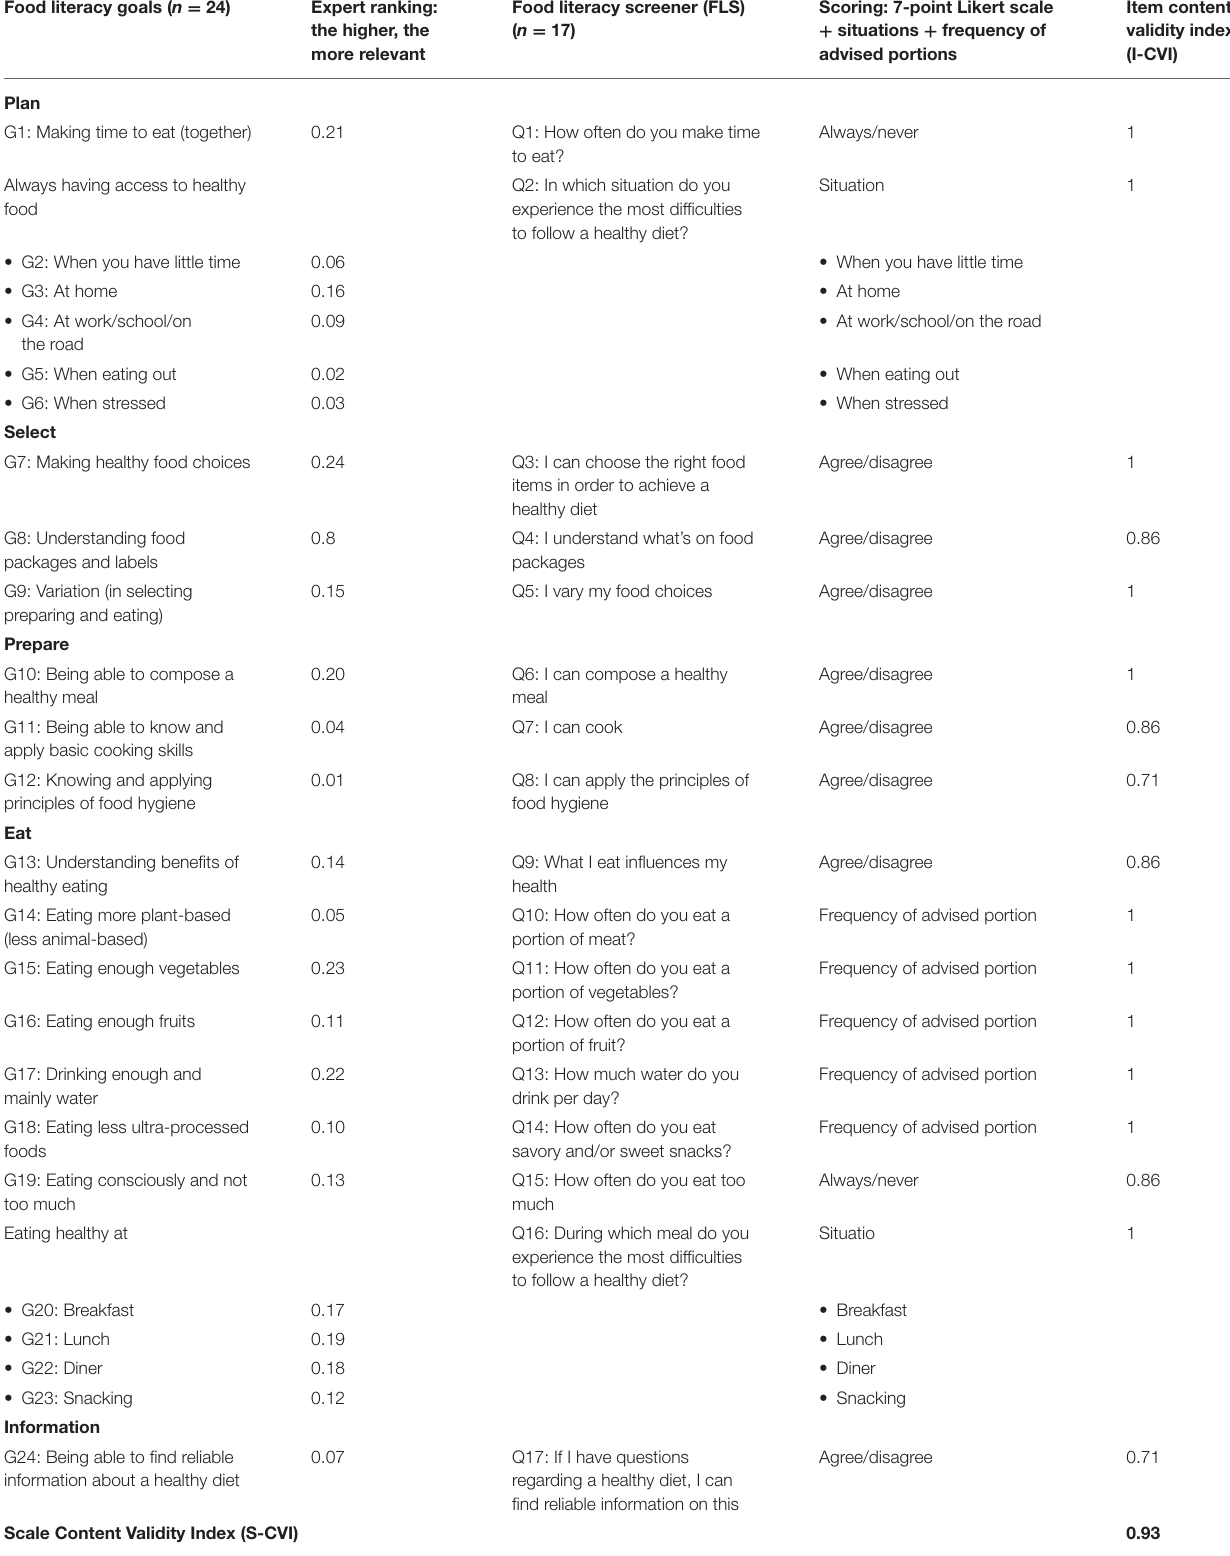
TABLE 1 | Overview of the food literacy goals, expert ranking, corresponding items of the FLS and I/S-CVI. Food literacy goals ( n =